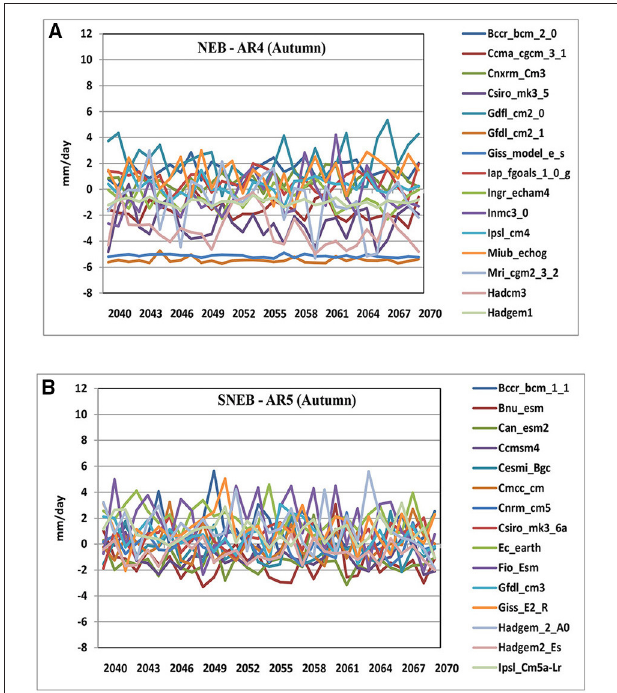
FIGURE 11 | Summer rainfall anomalies projected for eastern NNB from CMIP3-AR4 (A) and CMIP5-AR4 (B) models over the period 2040-2070.